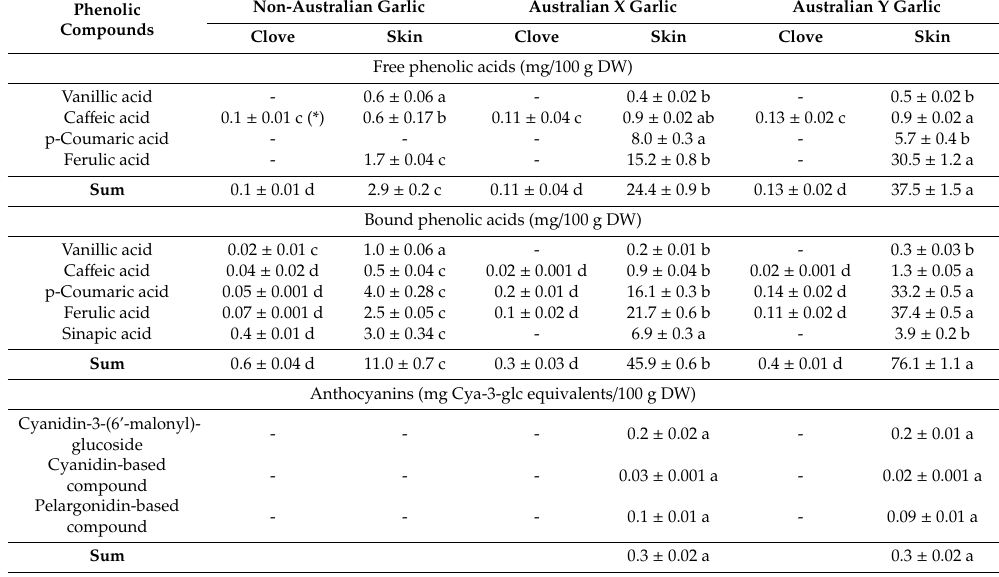
Table 3. Content of phenolic acids and anthocyanins in the garlic samples studied. Phenolic